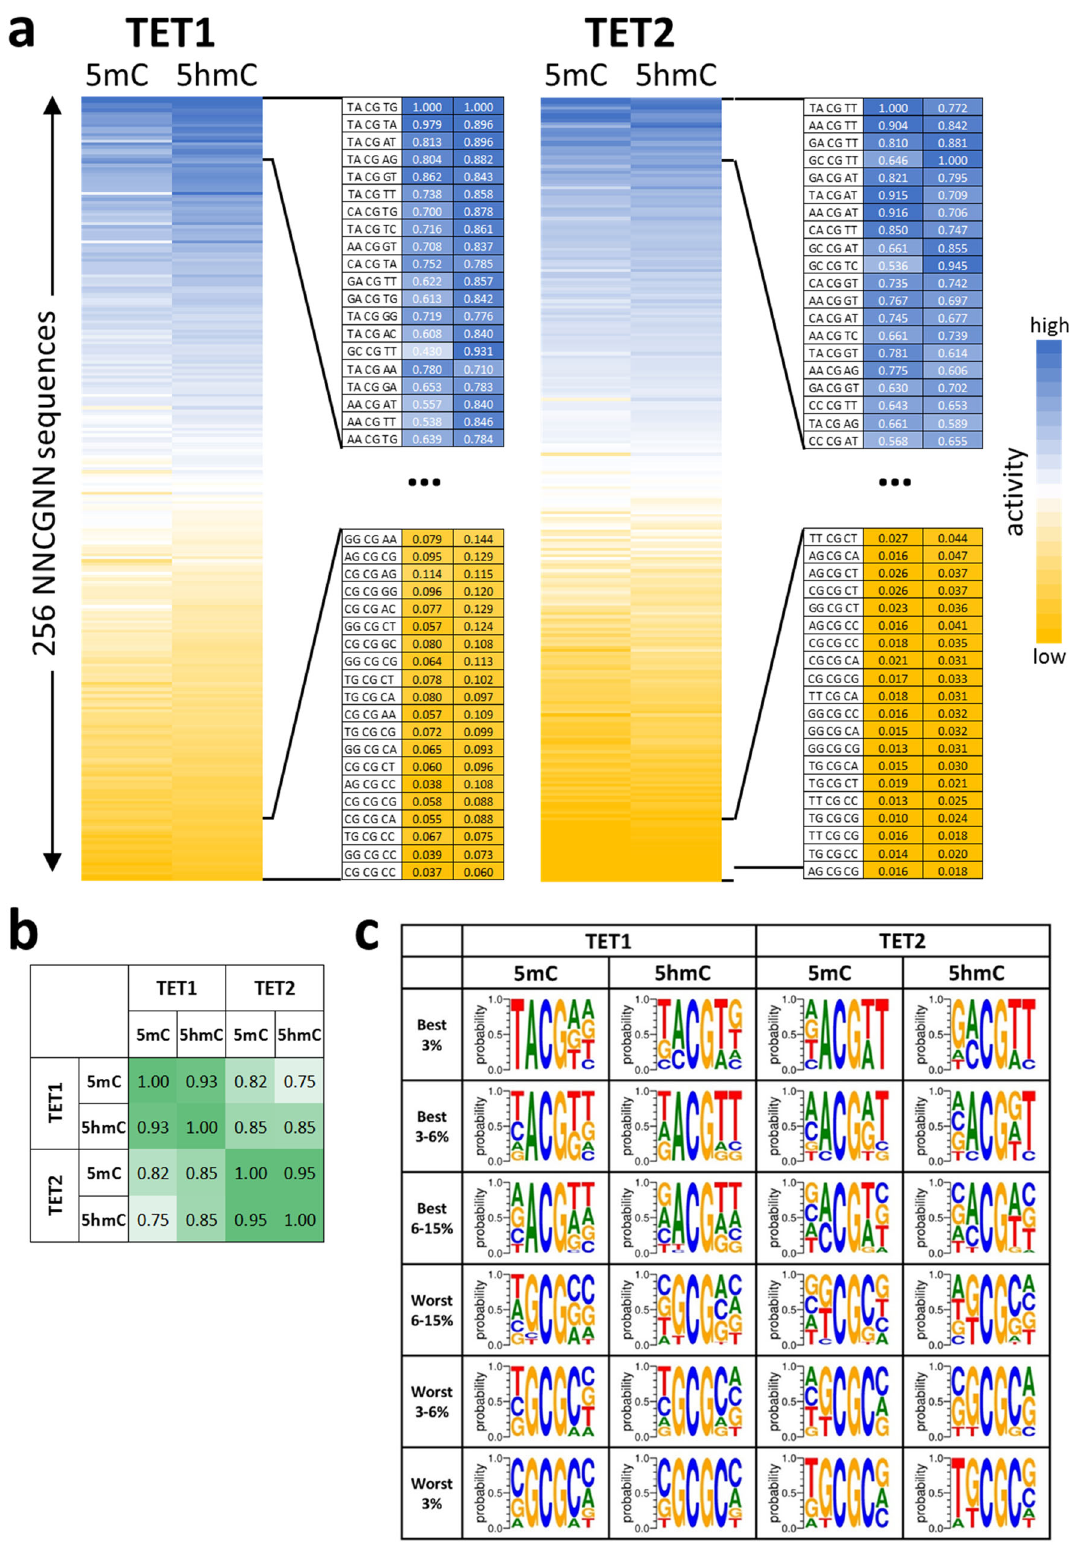
Fig. 2 Flanking sequence effects on the oxidation of mCpG and hmCpG substrates by TET1 and TET2. a Heatmap of the average activities of TET1 and TET2 at NNmCpGNN and NNhmCpGNN sites sorted by the average activity. The enlargements show the activity and sequence of the most preferred and disfavored fl anking sequences. b Pairwise Pearson correlation factors of the fl ank pro fi les shown in panel a . All data were compiled in Supplementary Data 1. c Weblogos of the enrichment of bases at the different fl ank positions in subsets of the most preferred and disfavored NNCGNN fl anking sequences. Weblogos were prepared using WebLogo 3 (http://weblogo.threeplusone.com/).